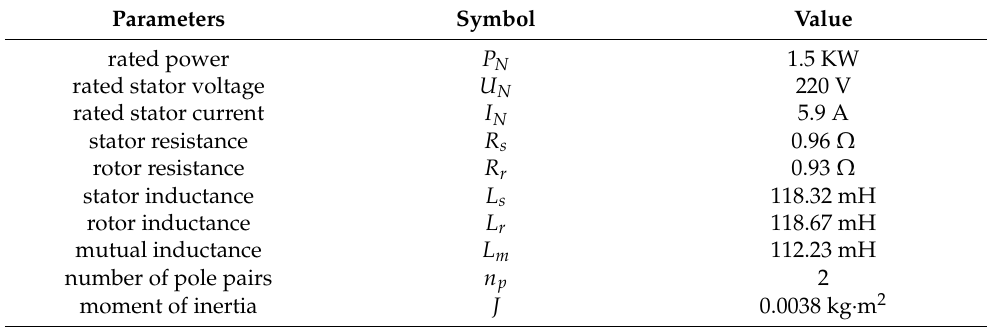
Table 1. Parameters of AM.